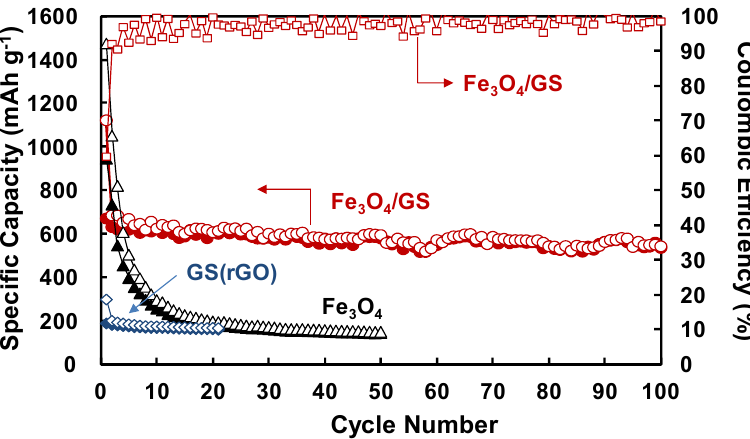
Figure 6. Cycling performances of GS, Fe Open and filled symbols denote discharge and charge capacities, respectively.